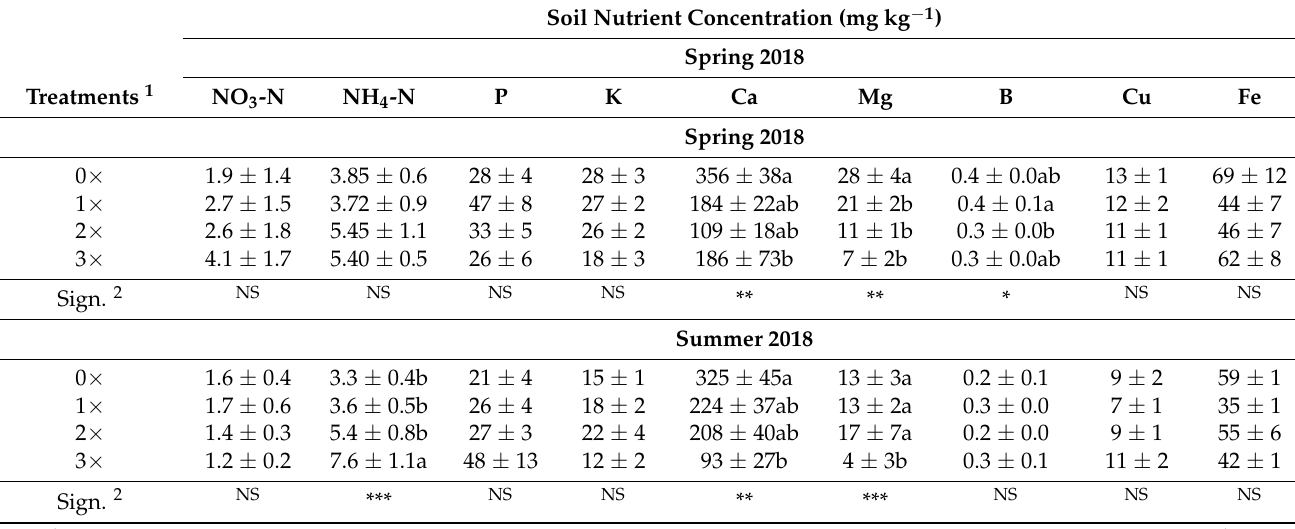
Table 3. Effect of split soil and /or foliar-applied essential nutrients on soil nutrient concentration in 0–15 cm soil depth under Huanglongbing-affected Hamlin citrus trees at Immokalee, FL during 2017 and 2018 growing